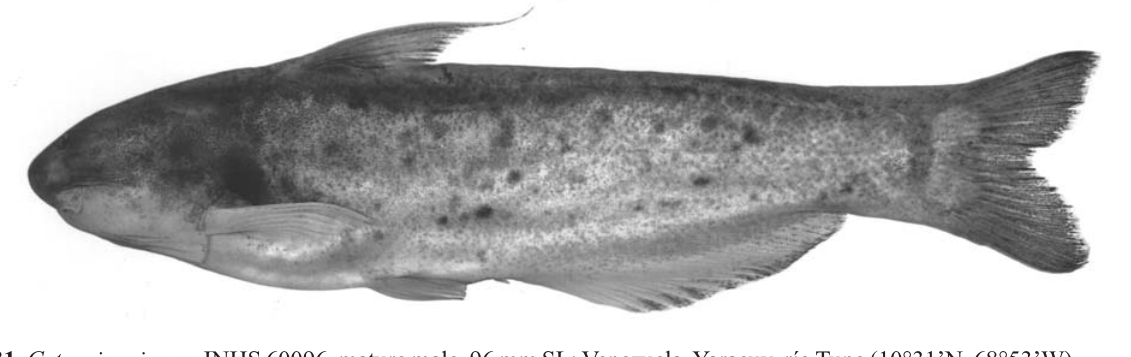
Fig. 31 . Cetopsis orinoco , INHS 60096, mature male, 96 mm SL; Venezuela, Yaracuy , río Tupe (10°31’N, 68°53’W).